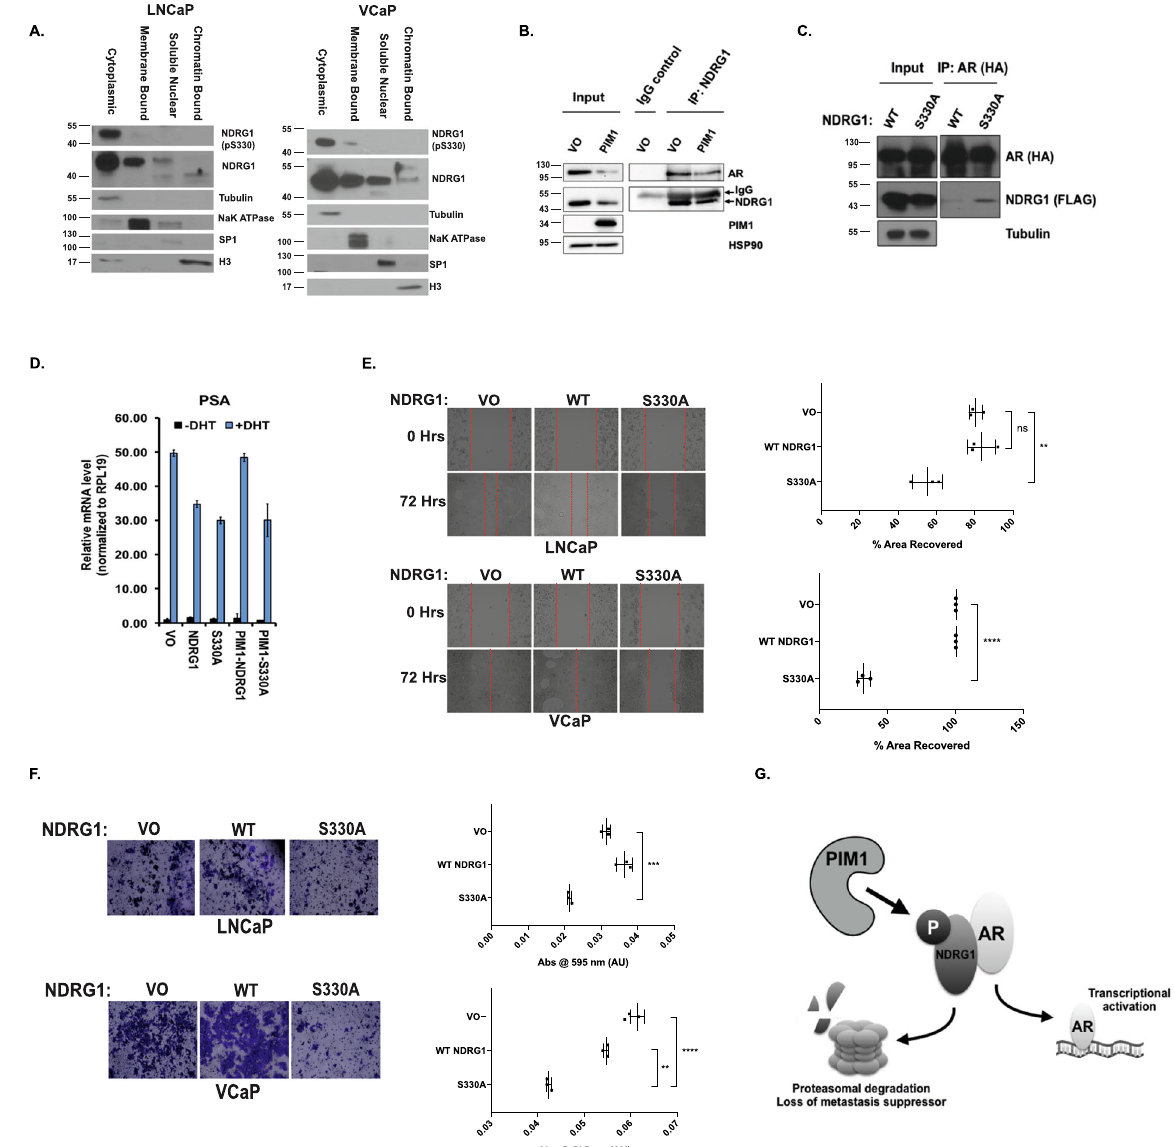
Fig. 6 NDRG1-AR interaction is modulated by NDRG1 phosphorylation. A LNCaP and VCaP cells were fractionated into membrane, cytoplasmic, soluble nuclear and chromatin-bound fractions and blotted for NDRG1 pS330 and NDRG1. Markers for each compartment were also blotted for to ensure the fi delity of the fractionation. B Endogenous NDRG1 co-immunoprecipitates with AR in LNCaP cells. C AR interacts more robustly with non-phosphorylated NDRG1. 293 T cells were transfected with either NDRG1 WT or NDRG1 S330A mutant (FLAG-tagged) and WT-AR (HA-tagged). AR was immunoprecipitated using HA beads, and Western blot performed for AR (HA) and NDRG1 (FLAG). D LNCaP transfected with indicated genes were steroid-starved for 48 h, and subsequently treated with 10 nM DHT. mRNA levels for PSA were measured relative to RPL19 by qRT-PCR. n = 3 and error bars represent the standard deviation. E – F Migration and matrigel invasion assays. LNCaP-PIM1 and VCaP-PIM1-expressing cells were transfected with vector only (VO), NDRG1 WT, or NDRG1 S330A. Cell migration was determined using a scratch assay. Micrographs of the cells at 0 and 72 h are shown, and percent area remaining after 72 h was quantitated. Invasion assay through matrigel was performed in LNCaP-PIM1 and VCaP-PIM1 cells expressing the indicated NDRG1 constructs, and cells invading through matrigel were stained and shown as micrographs. The stain was extracted from the cells that migrated through the matrigel and quantitated spectrophotometrically at 595 nm wavelength. n = 3 independent samples for each experiment. T test; ** p